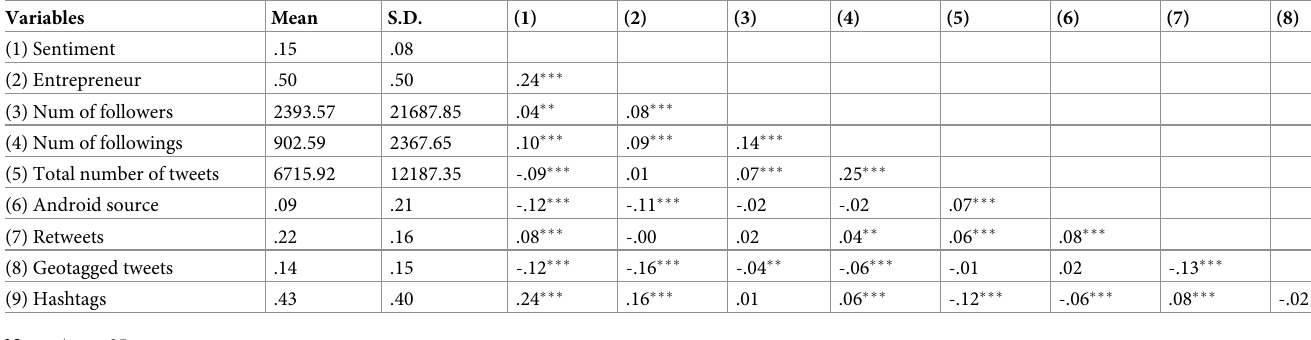
Table 2. Descriptive statistics and correlations for London data (N = 3,572).